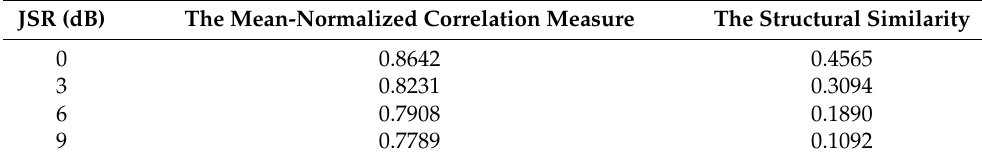
Table 2. Simulation results of jamming performance evaluation.